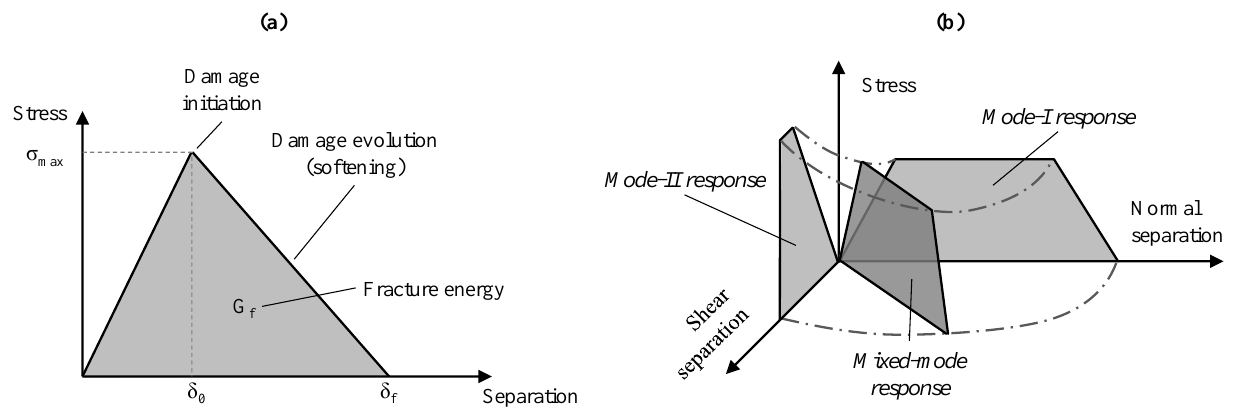
Figure 7. ( a ) Bilinear traction-separation law; ( b ) multidimensional traction-separation law with trapezoidal damage evolution.